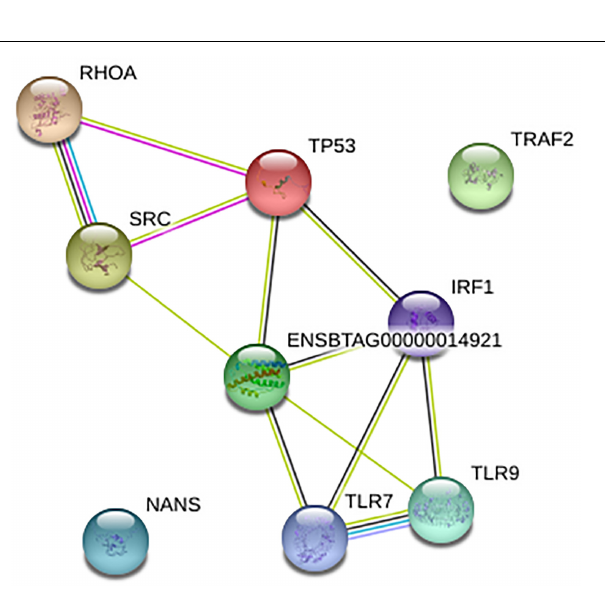
is the outgroup for Homo sapiens and Pteropus vampyrus ( Figure 6B ). Pan troglodytes is multiple nodes away from